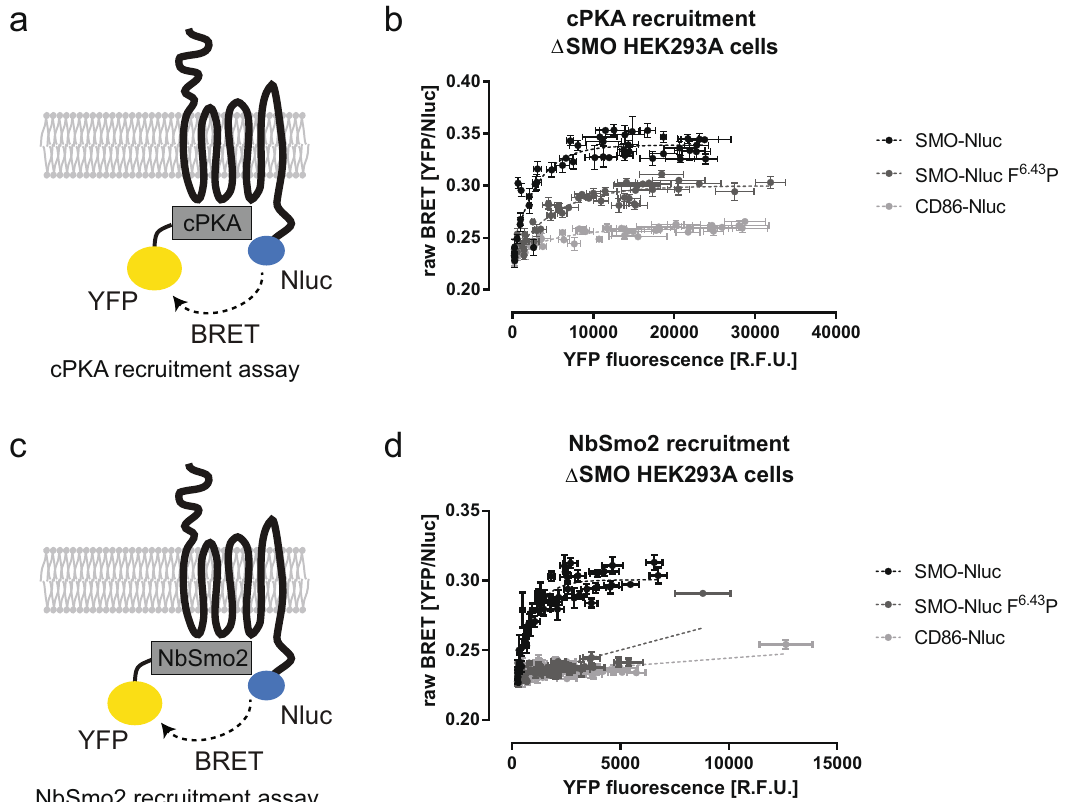
Fig. 4 cPKA and NbSmo2 recruitment to SMO. a Schematic presentation of the cPKA recruitment assay measuring direct BRET. b cPKA-YFP recruitment to SMO wild-type (black) and mutant (dark gray). CD86 (light gray) was employed as a negative control. c Scheme of the NbSmo2 recruitment assay measuring direct BRET. d NbSmo2-YFP recruitment to SMO wild-type (black) and mutant (dark gray). CD86 (light gray) was employed as a negative control. Experiments shown in b and d were conducted in Δ SMO HEK293 cells transiently co-transfected with the indicated receptor-Nluc construct and varying amounts of cPKA-YFP ( b ) or NbSmo2-YFP ( d ), respectively. Data show mean ± SD from four individual experiments conducted in quadruplicates. Each dataset was fi tted to a one-phase association or linear model and the preferred fi t was selected based on an Extra sum-of-squares F-test ( P < 0.05). See Supplementary Fig. 6f for the cell-surface expression data of the receptor-Nluc constructs. Source data are provided as a Source Data fi